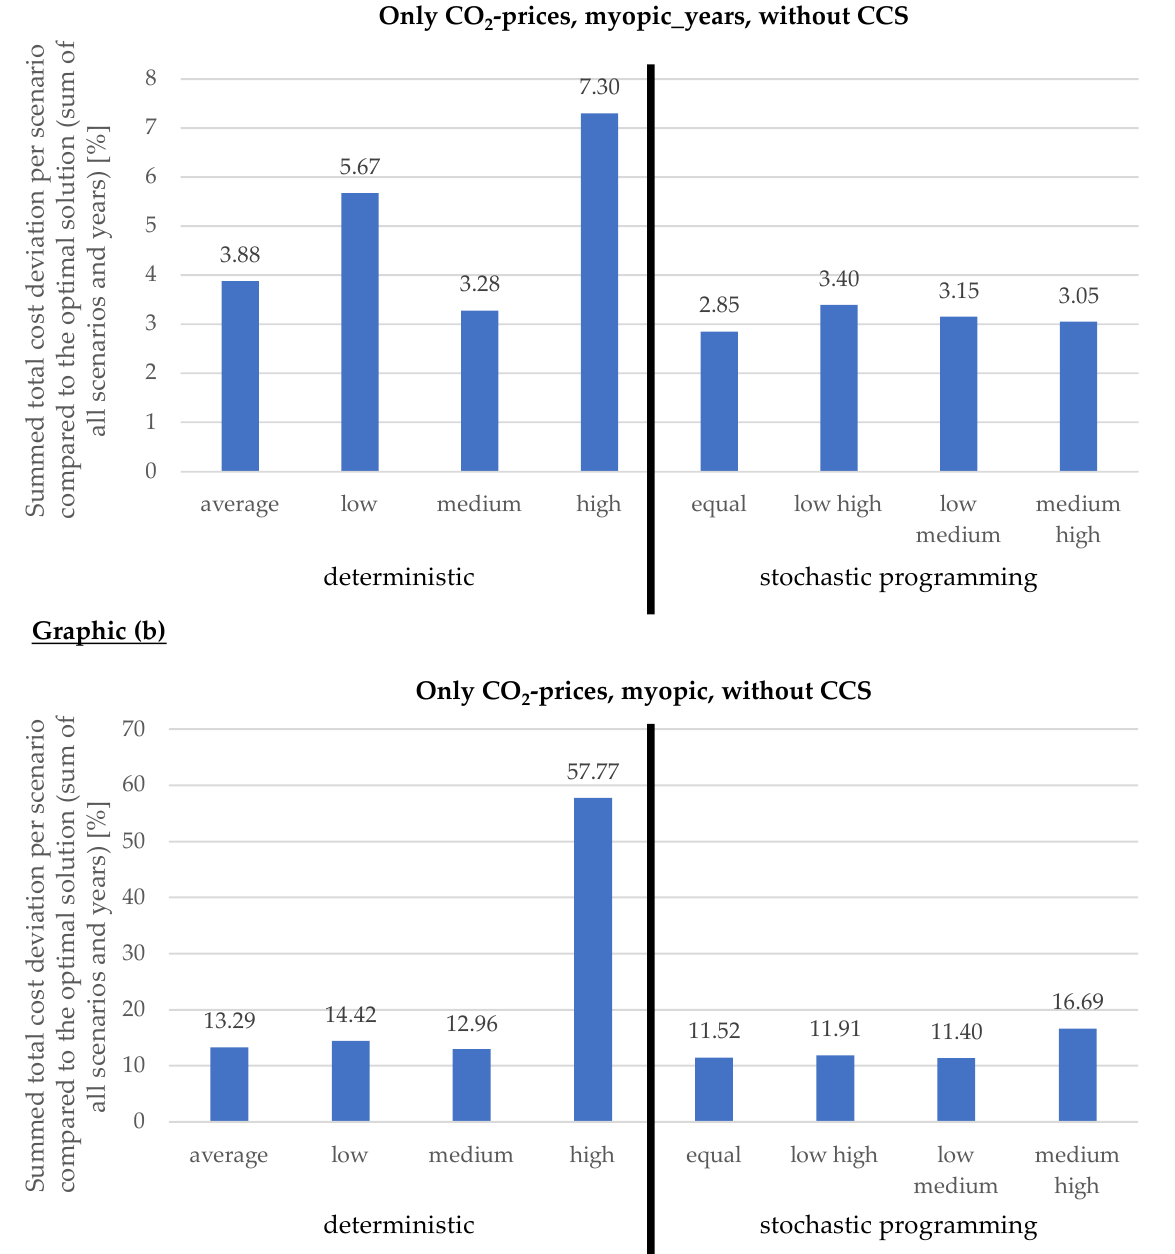
Figure 15. ( a ) STCD per scenario for uncertain CO 2 prices (myopic_years, without CCS); ( b ) STCD per scenario for uncertain CO 2 prices (myopic, without CCS).